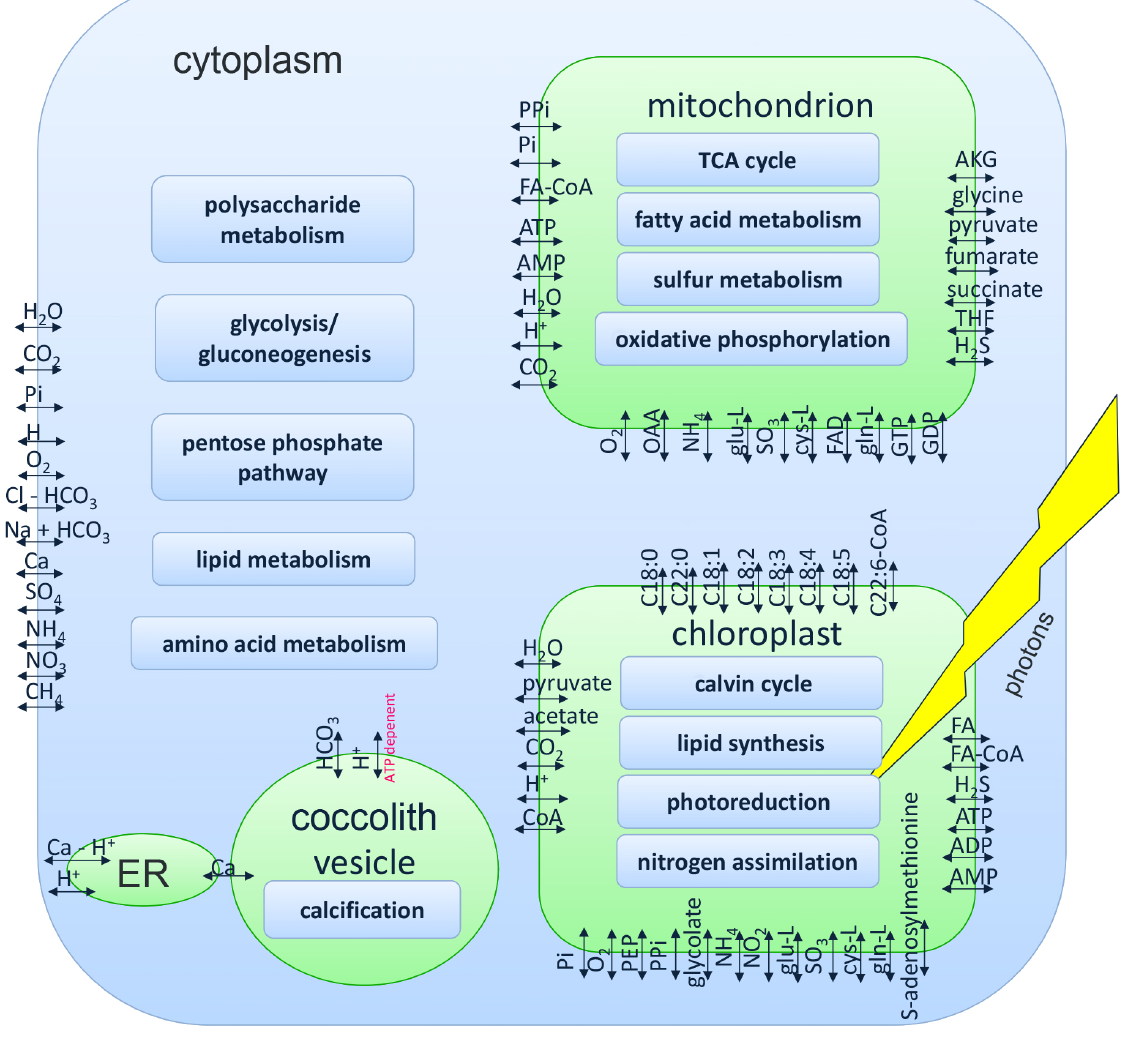
Figure 3. Transport reactions an the localization of major pathways in the iEH410 metabolic reconstruction of Emiliania huxleyi